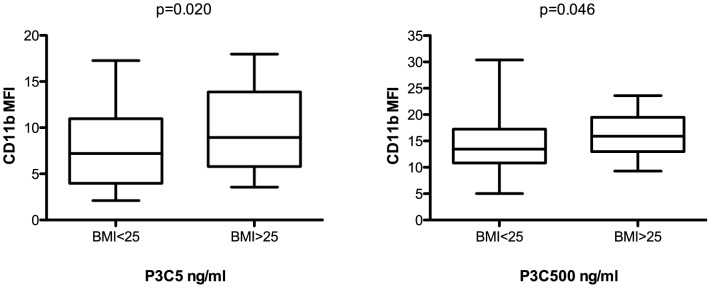
Single dose TLR response in relation to BMI.CD11b expression after stimulation with P3C 5 ng/ml (left) and P3C 500 ng/ml (right) was significantly higher in patients with a BMI>25 as compared to normal weight patients (BMI<25). Whiskers are presented as 5–95 percentile. Data were statistically tested with a Mann Whitney U test.